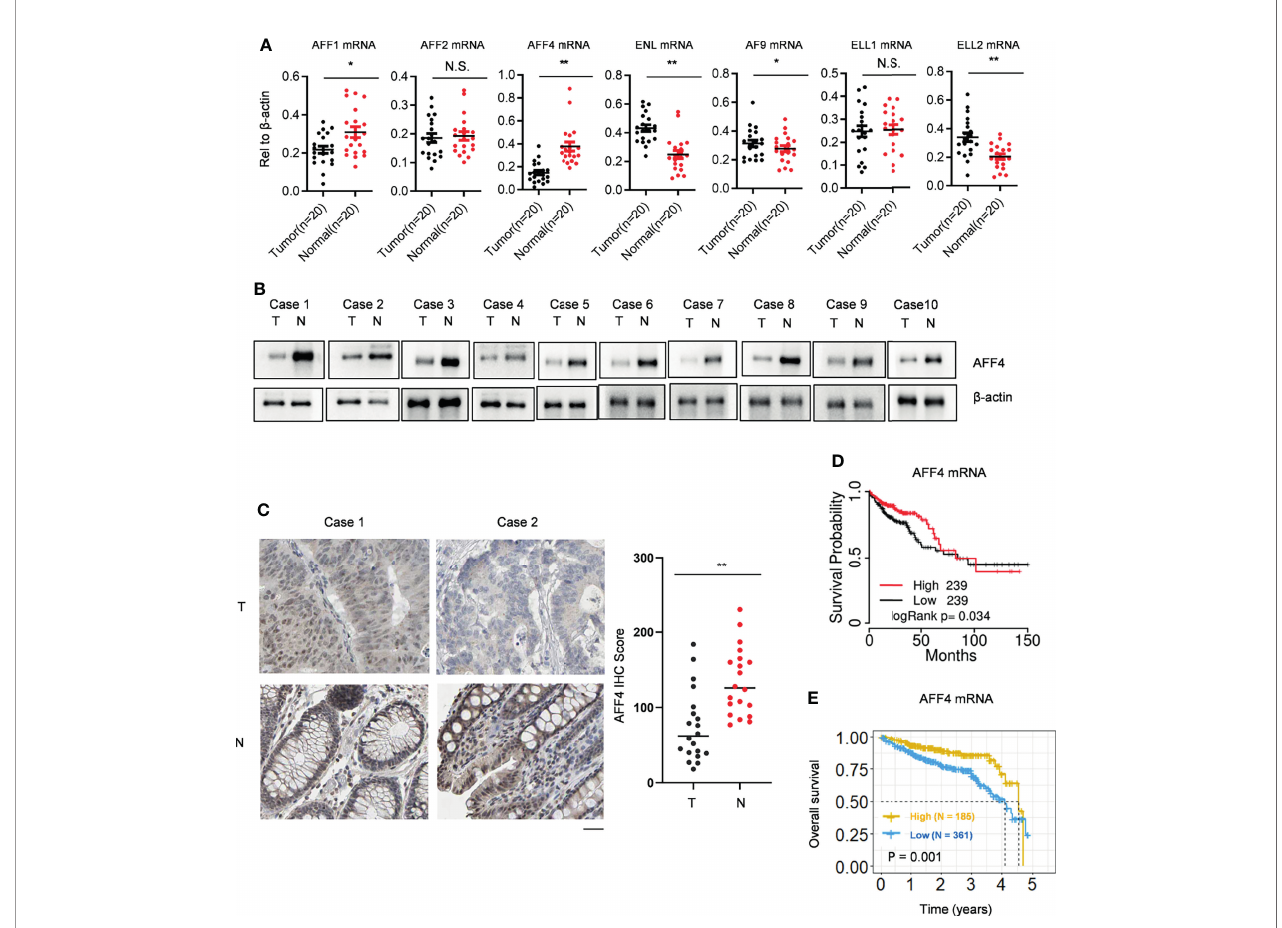
FIGURE 1 | AFF4 is downregulated in CRC tissue and reversely predicts poor prognosis. (A) SEC components, including AFF1/2/4, ENL/AF9, and ELL1/2 are listed, and their gene expressions were determined by qRT-PCR in clinical colorectal cancer and adjacent tissues collected by Ruijin Hospital. Total RNA of 20 pairs of colorectal cancers and their adjacent normal tissues were extracted, and b -actin was performed as an internal control. Primers against mRNA level of above genes are listed in Materials and Methods section. *p < 0.05; **p < 0.01; NS, not signi fi cant. (B) Total protein in 20 pairs of colorectal cancers and their adjacent normal tissues were extracted by strong lysis buffer and centrifugation, and b -actin was performed as an internal control. Indicated antibodies testing AFF4 protein level is listed in Materials and Methods section. (C) Immunohistochemistry (IHC) was performed to detect AFF4 distribution in the 20 pairs of colorectal cancers and their adjacent normal tissues using antibody speci fi cally against AFF4 in tissue level (left). The IHC score was calculated and analyzed in right panel. The results of IHC assay and the statistic method of IHC are described in the Materials and Methods section. (D) The survival time information of 478 CRC patients were extracted from TCGA database and a median cutoff separately divided these patients into two groups: high ( N = 239) and low ( N = 239). The longest statistic time is 150 months. (E) The survival time information of 546 CRC patients in 5 years were extracted from the Human Protein Atlas database and a best cutoff separately divided these patients into two groups: high ( N = 185) and low ( N = 361). The value of best cutoff is